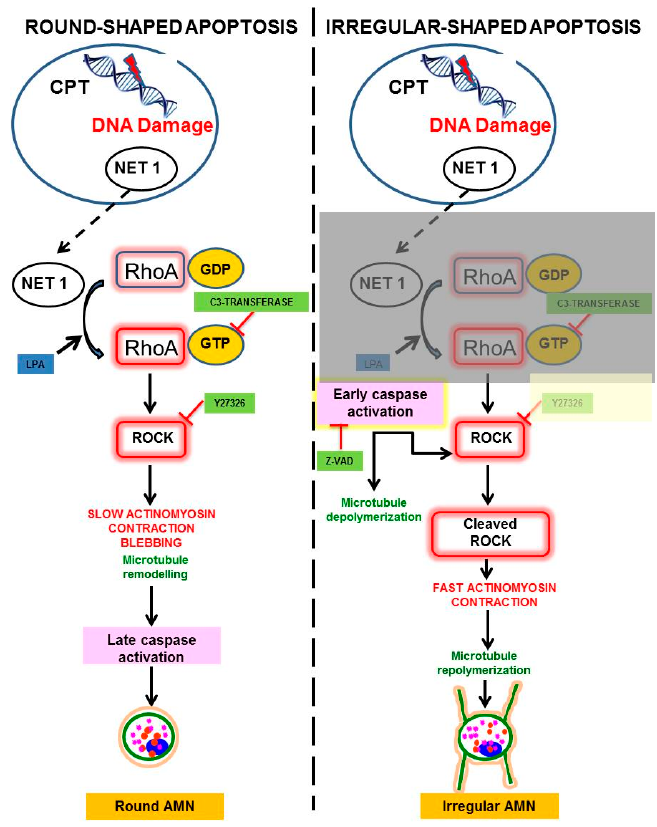
Figure 3. Schematic representation of signalling pathways involved in cytoskeleton reorganizations in round and irregular apoptosis. T arrow=inhibition; dashed arrow= translocation from nucleus to cytosol; solid arrow=activation; shaded area= disruption by caspases. Irrespective of the localization of RhoA activation by Net1, it activates its downstream effector, the Rho-associated coiled-coil protein kinase 1 (ROCK-1). Next, ROCK phosphorylates myosin light chain phosphatase (MLCP), which in turns increases the phosphorylation levels of myosin light chain II (MLC). As a